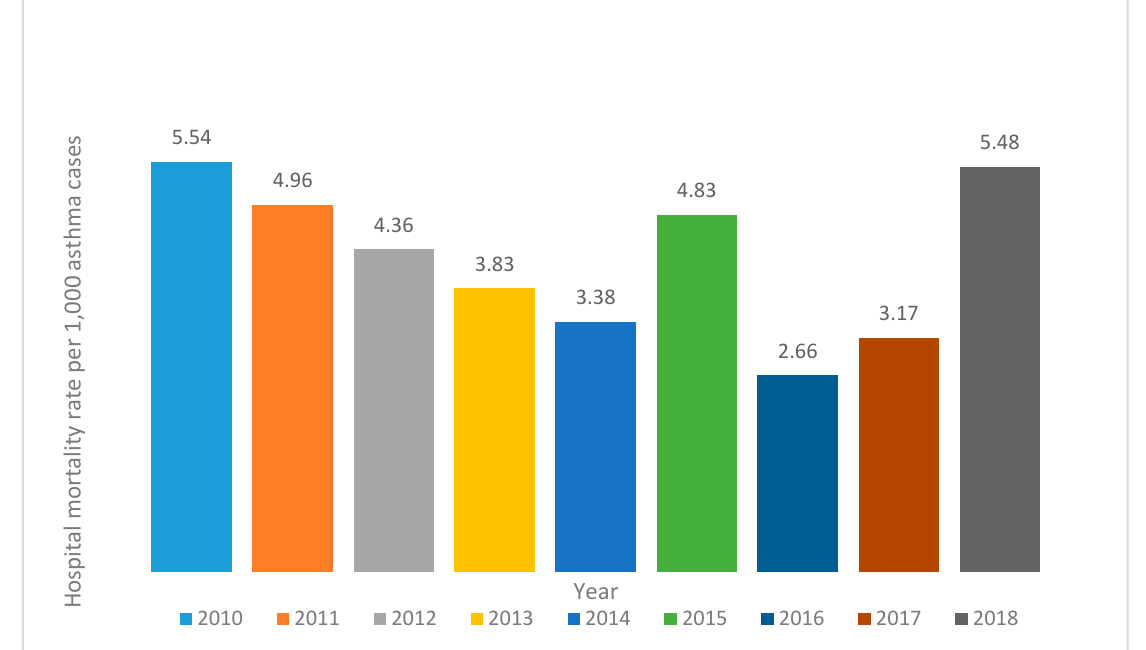
Figure 3. Asthma mortality rate per 1000 hospitalizations in Mexico from 2010 to 2018.